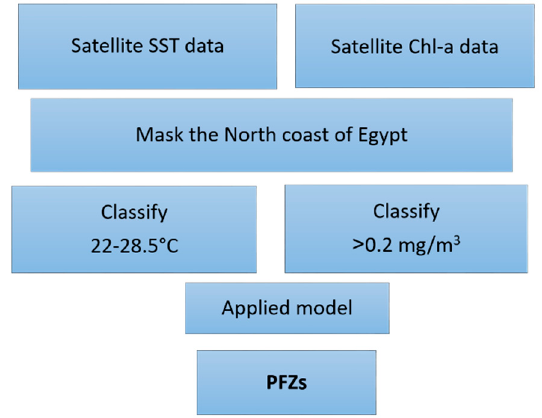
Figure 3. The method applied to detect the